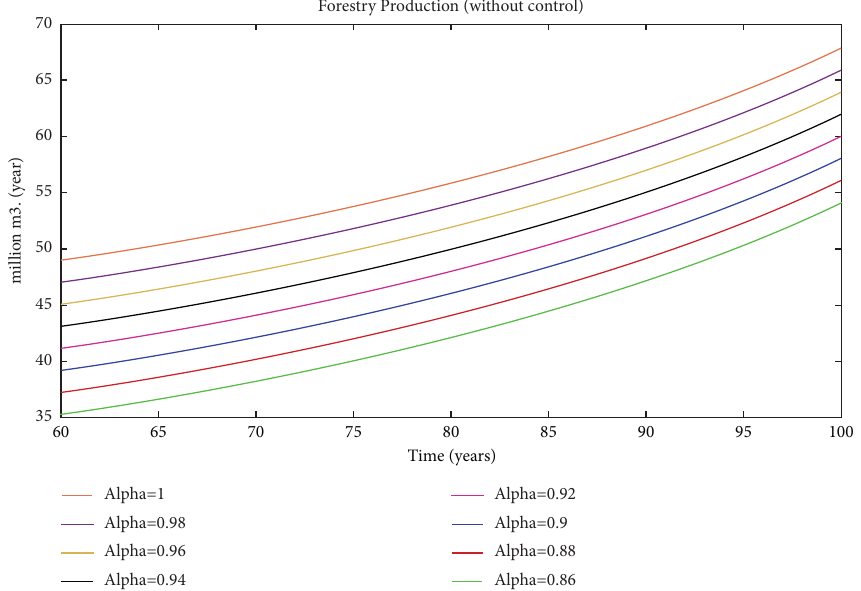
Figure 8: Comparison of the forestation rate without control with diferent values of comparison of the forestation rate without control with with diferent values of α , Figure 11 represents compar- diferent values of α , Figure 9 represents comparison of ison of the forestation rate with control with diferent GDP without control with diferent values of α , Figure 10 values of α , and Figure 12 represents comparison of GDP represents comparison of the amount of CO with control with diferent values of α . with control 2